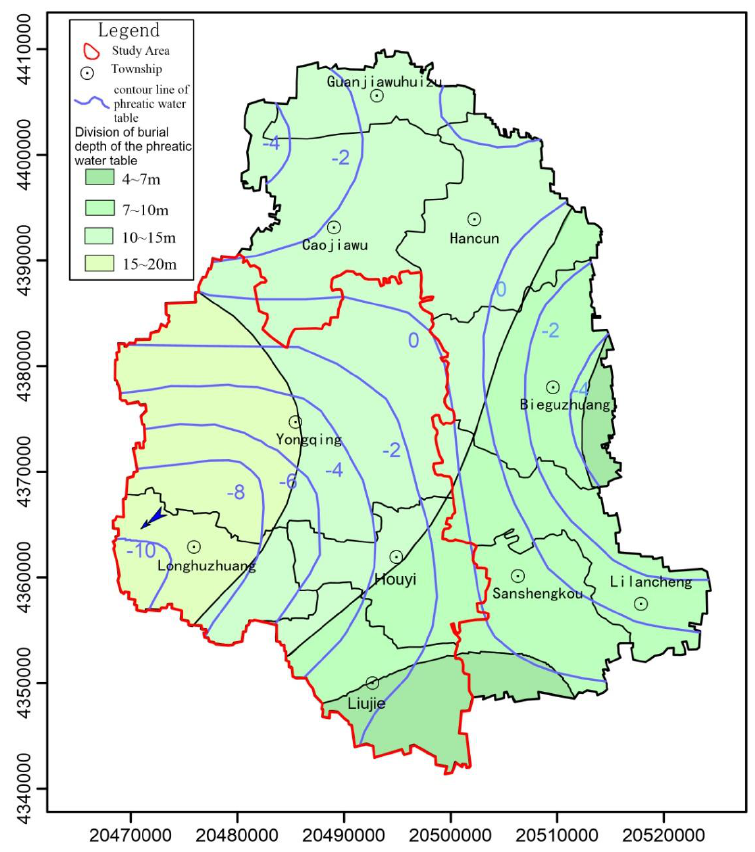
Figure 10. Hydrogeochemical inverse simulation path in the study area. W6 and W12 were selected as the upstream and downstream, respectively. The hydrochemical characteristic results observed at these two sampling points were used as input data in the PHREEQC simulation software to perform inverse hydrogeochemical simulation. In addition, the uncertainty limit was set at